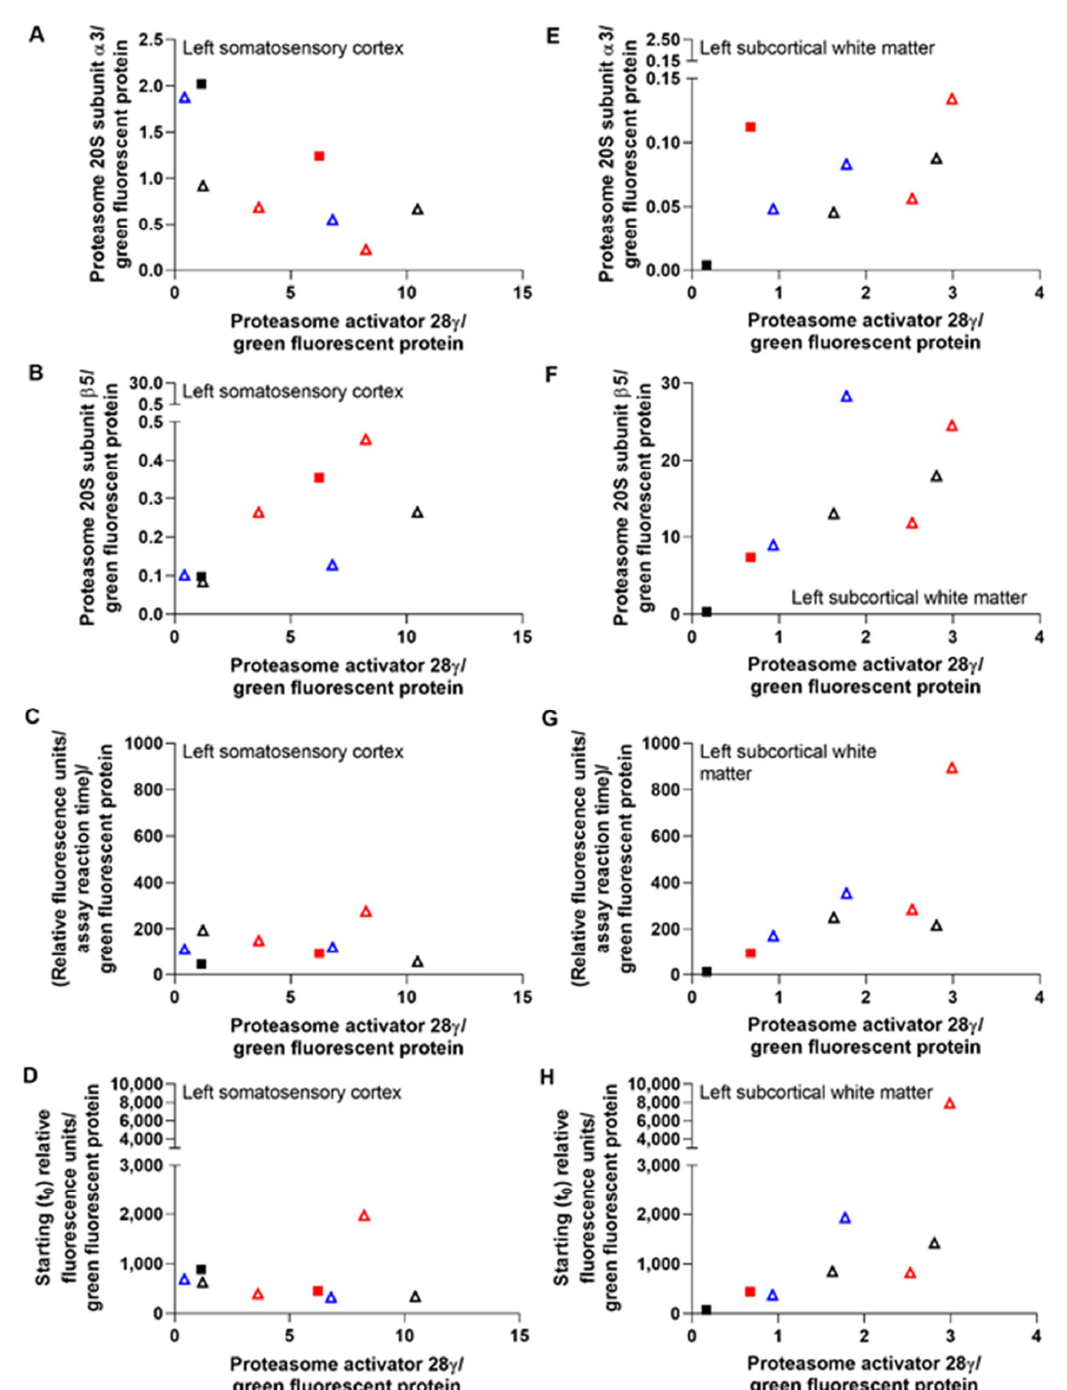
Figure 9. Correlations between immunoreactivity for PA28 γ and proteasome 20S subunits α 3 and β 5 and between PA28 γ and proteasome activity in piglets that received left intracerebral adeno-associated virus (AAV). Data from the somatosensory cortex ( A – D ) and subcortical white matter ( E – H ) are shown. PA28 γ and α 3 levels had a negative correlation in the cortex (r = − 0.833, p = 0.015, A ) but no relationship in white matter (r = 0.595, p = 0.132, E ). PA28 γ correlated positively with β 5 in the cortex (r = 0.738, p = 0.046, B ) and white matter (r = 0.810, p = 0.022, F ). The PA28 γ level also correlated with the slope of white matter proteasome activity over assay reaction time (r = 0.833, p = 0.015, G ) and starting t 0 activity (r = 0.857, p = 0.011, H ). This relationship did not occur in the cortex (slope: r = 0.143, p = 0.752, C ; t 0 : r = − 0.405, p = 0.327, D ). The shapes of the data points indicate the cerebral hemispheric AAV dose: square = 2 × 10 10 –2 × 10 11 genome copies (gc) and triangle = 5 × 10 10 –5 × 10 11 gc. Black: AAV-GFP control, red: AAV-shRNA to PA28 γ -GFP, and blue AAV-PA28 γ -GFP (enforce). Piglets represented by an open symbol also received the adjuvant (40 ng of F108 and 2.5 µ g of